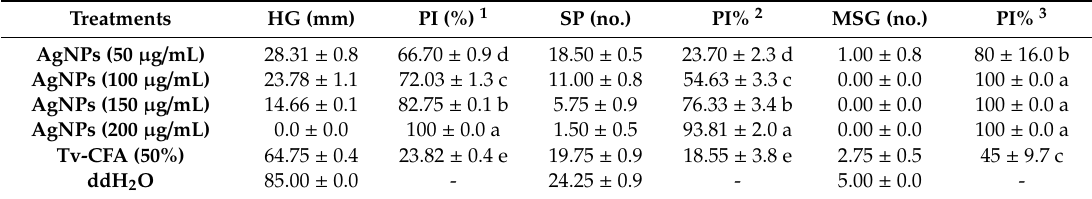
Table 2. E ff ect of AgNPs of di ff erentconcentrations against the hyphal growth(HG), sclerotia production (SP), and myceliogenic germination of sclerotia (MSG) of S. sclerotiorum. Treatments